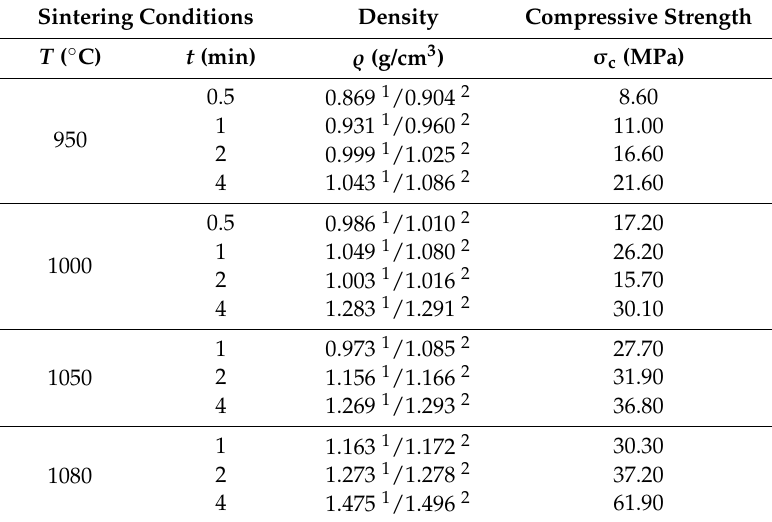
Table 1. Density and compressive strength values for Cu-coated cenospheres (Cu@CS) as measured on cylindrical samples.